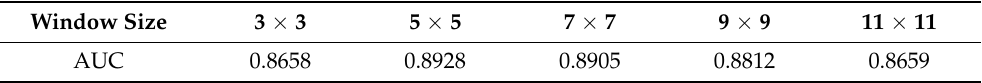
Figure 8. The ROC curve of detection results obtained from different window sizes ranging from 3 × 3 to 11 × 11 on the proposed texture-based method. Table 3. The comparison of AUC for selected window size.